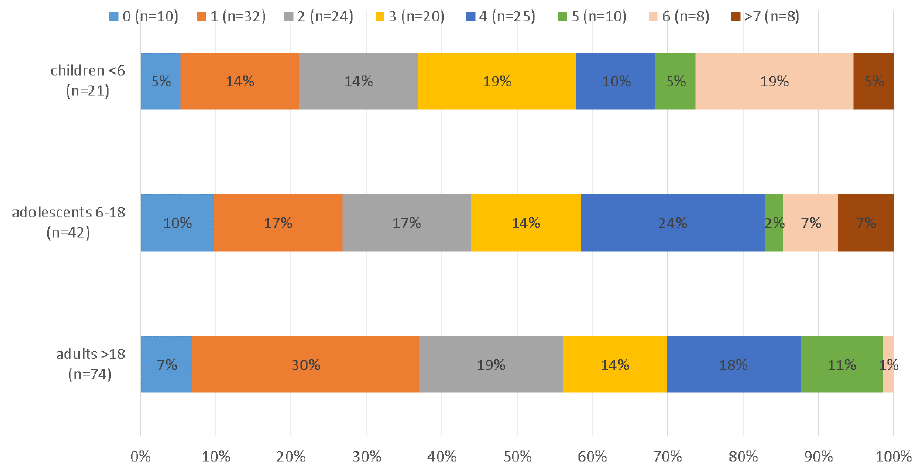
Figure 2. Number of infecting pathogens stratified by age in years.